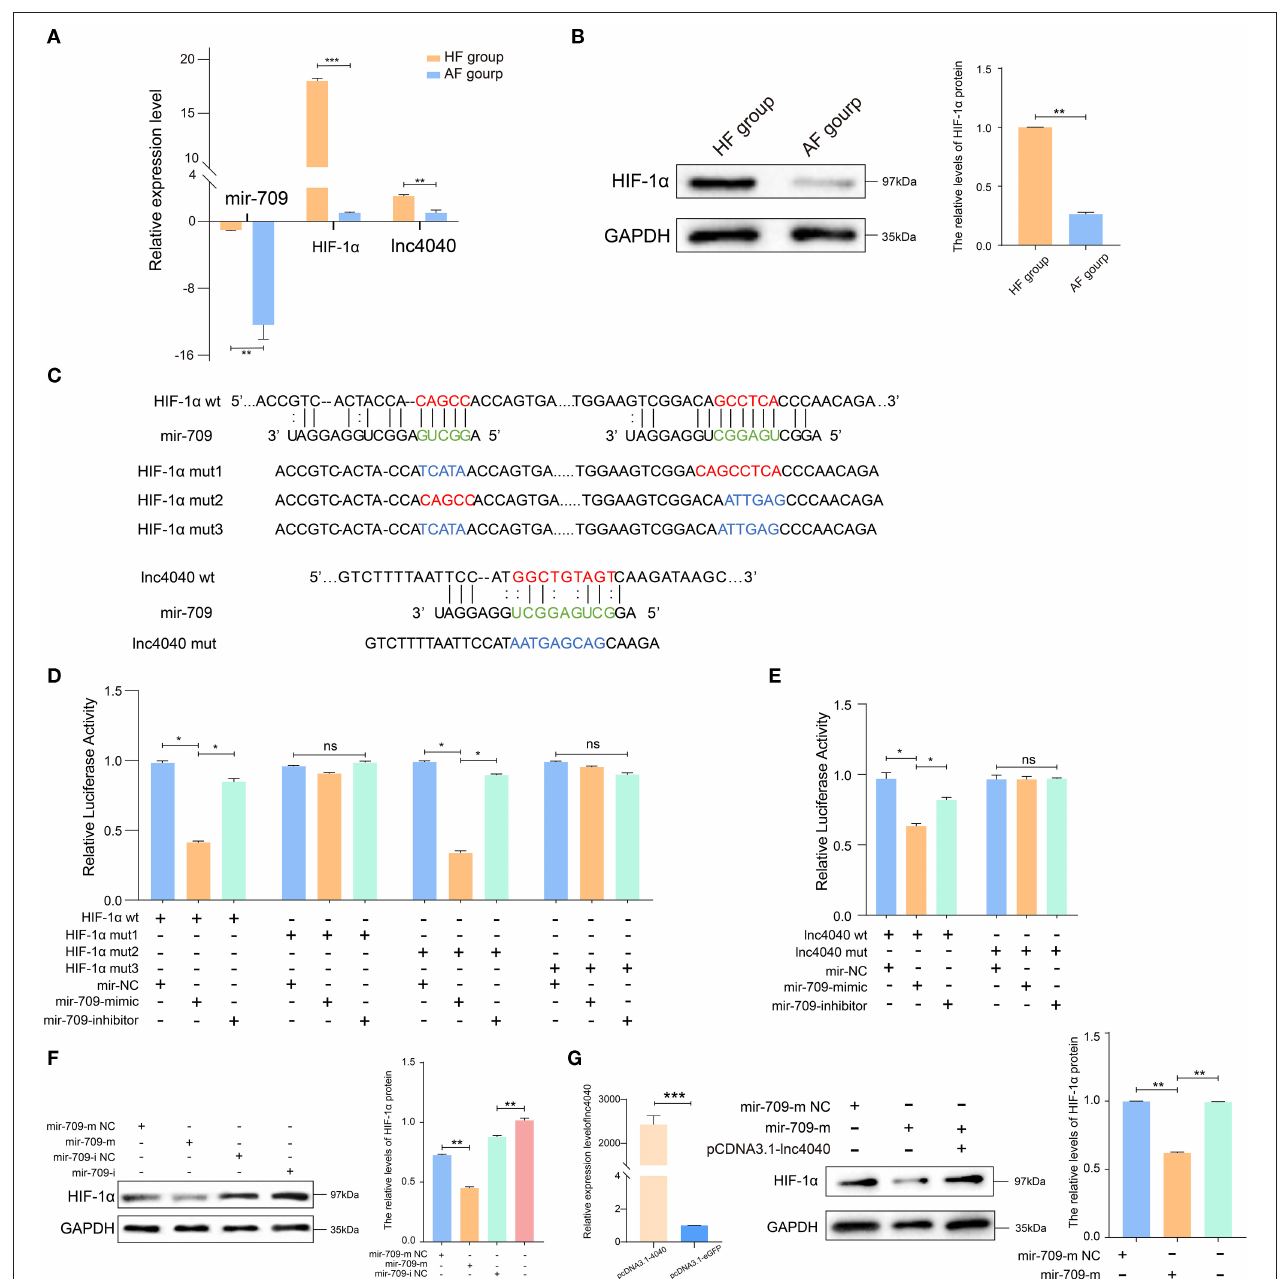
FIGURE 6 | Experimental validated of ceRNAs regulation with miR-709. (A) Relative expression levels of miR-709, Hif1a , and lnc4040 in GCs between HFs and AFs. (B) Expression of HIF1A protein in GCs between HFs vs. AFs and quantified by ImageJ (v1.45), error bars represent SEM ( n = 3) ** p < 0.01. (C) Predicted miR-709-binding site on Hif1a and lnc4040, and design of luciferase reporter. (D) 293T cells were co-transfected with wild-type (WT) or mutant (MUT) luciferase reporters of Hif1a with miR-709 mimics, mimics NC, or miRNA inhibitors. The relative levels of firefly luminescence normalized to Renilla luminescence are plotted. Error bars represent SEM ( n = 3) * p < 0.05. (E) 293T cells were co-transfected with wild-type (WT) or mutant (MUT) luciferase reporters of lnc4040 with miR-709 mimics, mimics NC, or miRNA inhibitors. The relative levels of firefly luminescence normalized to Renilla luminescence are plotted. Error bars represent SEM ( n = 3) * p < 0.05. (F) Expression of HIF1A protein in GCs infected with miR-709 mimics, mimics NC, miR-709 inhibitor, and inhibitor NC and quantified by ImageJ (v1.45); error bars represent SEM ( n = 3) ** p < 0.01. (G) Expression of HIF1A protein in GCs infected with miRNA mimics, mimics NC, and lnc4040 overexpression vector and quantified by ImageJ (v1.45); error bars represent SEM ( n = 3) ** p < 0.01.